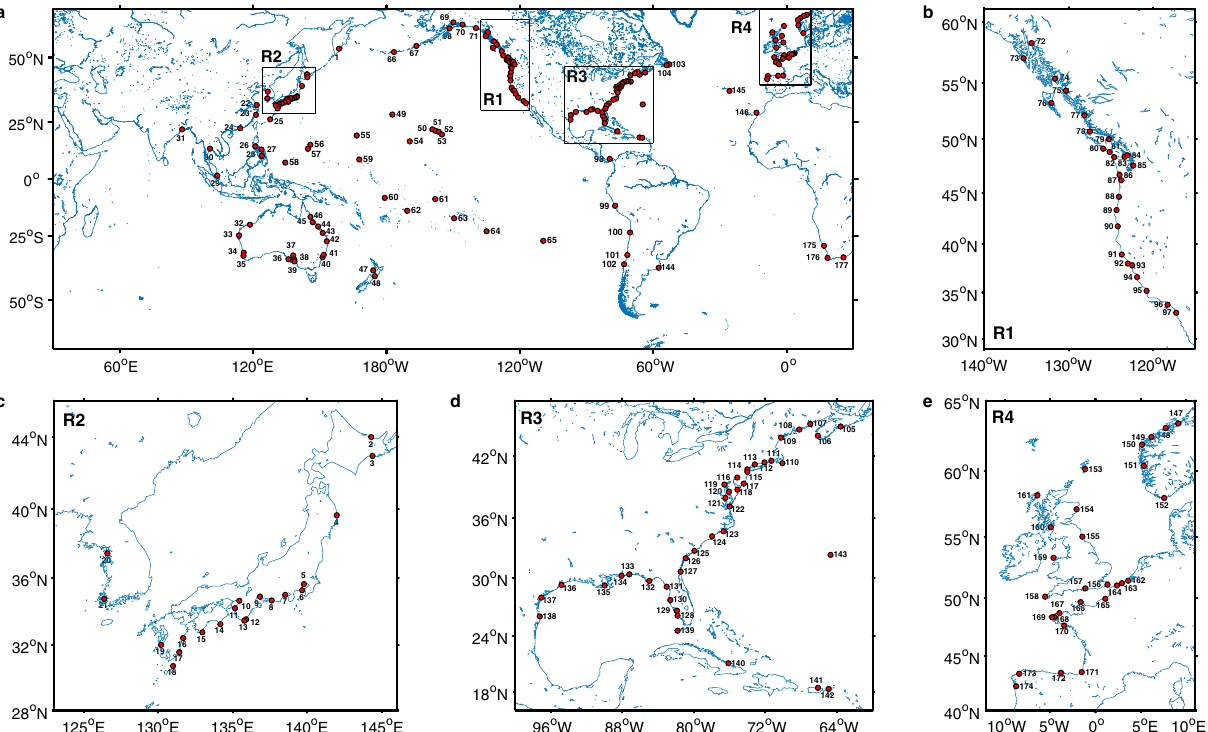
Fig. 2 Locations of tide gauges. a 177 tide-gauge (TG) stations used in this study (red circles). East coast of Paci fi c Ocean (EP) with TG identi fi cation (ID) number 66 – 102 including region R1 ( b ) contains 37 records. Asia nearby coastline (TG ID 1 – 31) contains 31 records, with an expanded region R2 ( c ) for details. Oceania (including Australia and New Zealand, TG ID 32 – 48) contains 17 records. The central Paci fi c Ocean (CP, TG ID 49 – 65) contains